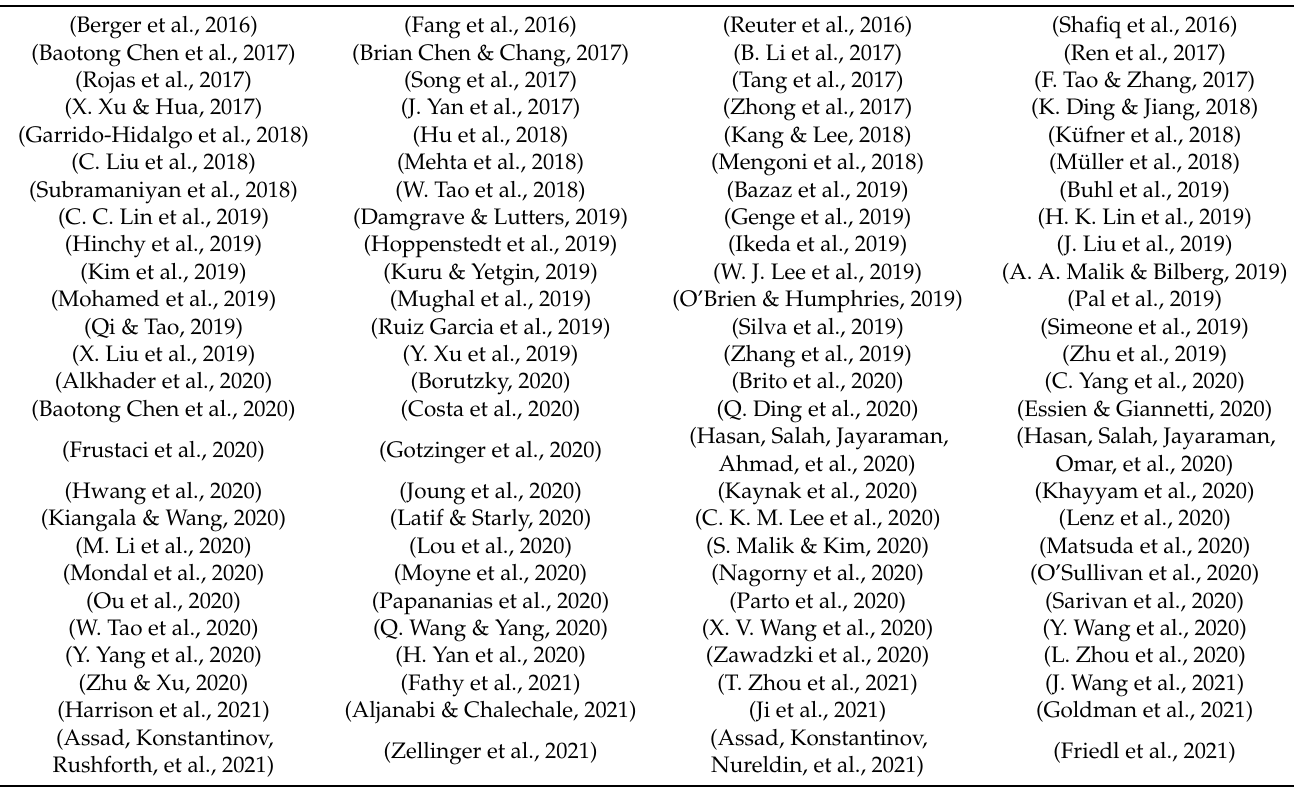
Table A1. Articles in alphabetical order per year [114–138].